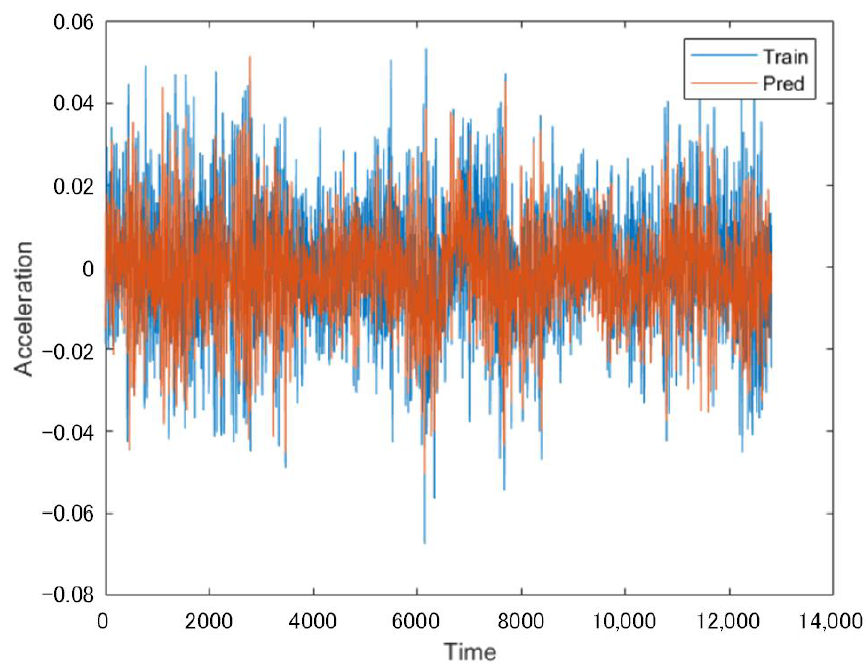
Figure 10. Comparison of vibration acceleration from Channel 8.